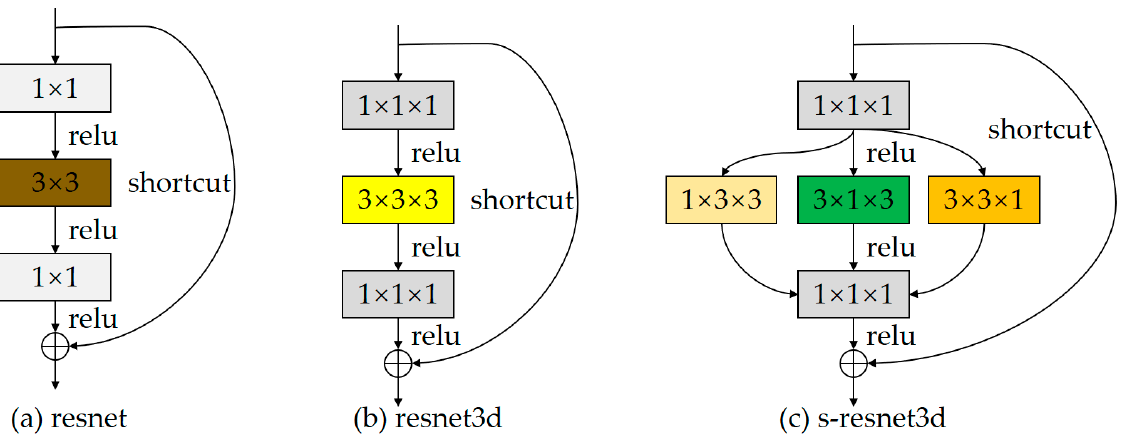
Figure 3. A “bottleneck” residual building block for resnet ( a ), resnet3d ( b ) and s-resnet3d ( c ). ( a ) shows the original residual network, ( b ) shows the 3d residual network after inflating the convolu- tional kernel, and ( c ) shows the spurious 3d residual network using 3 different convolutional kernels. The remainder of this paper is organized as follows. In Section 2, we first intro- duce classical video action recognition methods, from traditional manual features to